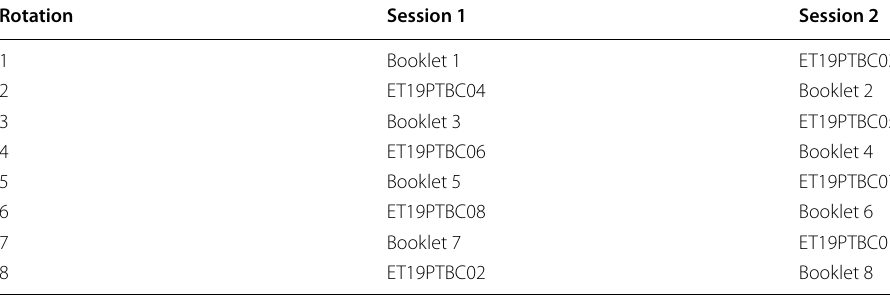
Table 3 Counterbalanced booklet rotation design—fourth and eighth grades